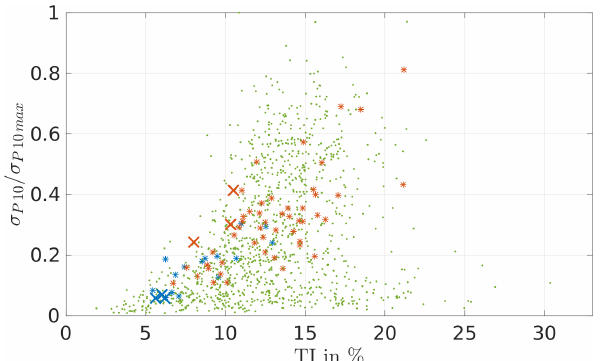
Figure 13. Standard deviation of the power with respect to the TI determined from measurement data (green – all wind speeds; blue and red asterisks – stable and neutral measurements at wind speeds of 8–9ms − 1 ) in comparison to the simulation results ( ×